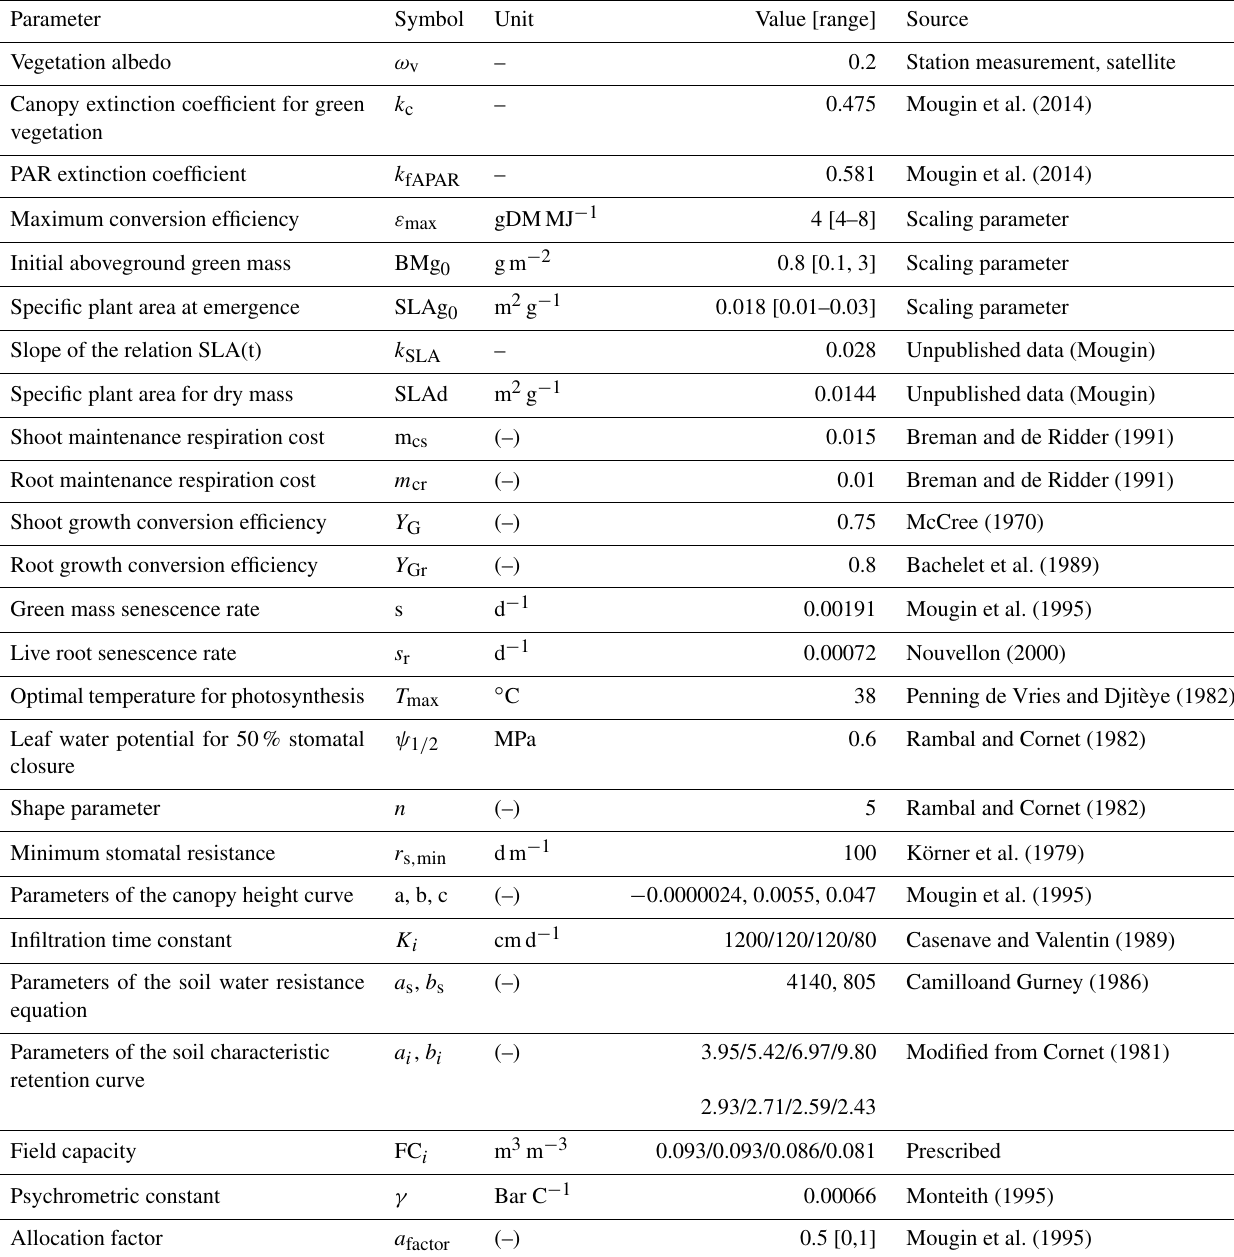
Table A3. Model parameters used to run the STEP–GENDEC– NOFlux